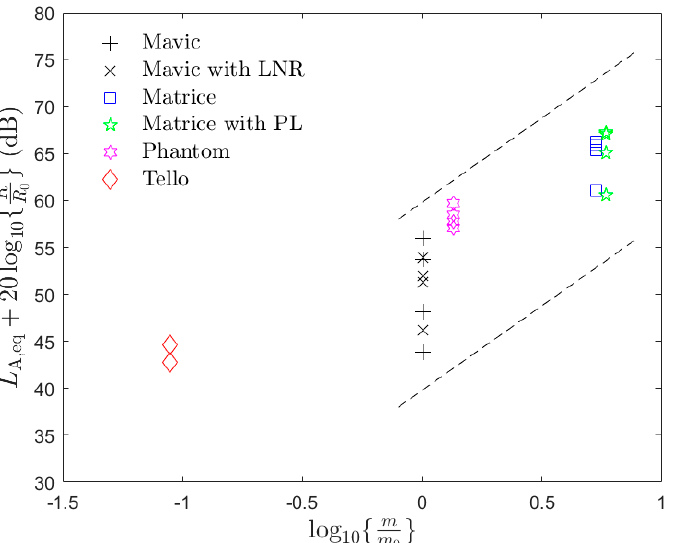
Figure 6. Plot of ‘distance-corrected’ L A,eq versus log (cid:2869)(cid:2868) (𝑚/𝑚 (cid:2868) ) . 𝑚 is the nominal mass of the UAV, m 0 = 0.9 kg is a reference mass, R is the distance between the UAV and the microphone location and √ R 0 = 10 2 m is a reference distance. The straight lines have gradients of 1.8, consistent with the scaling law in